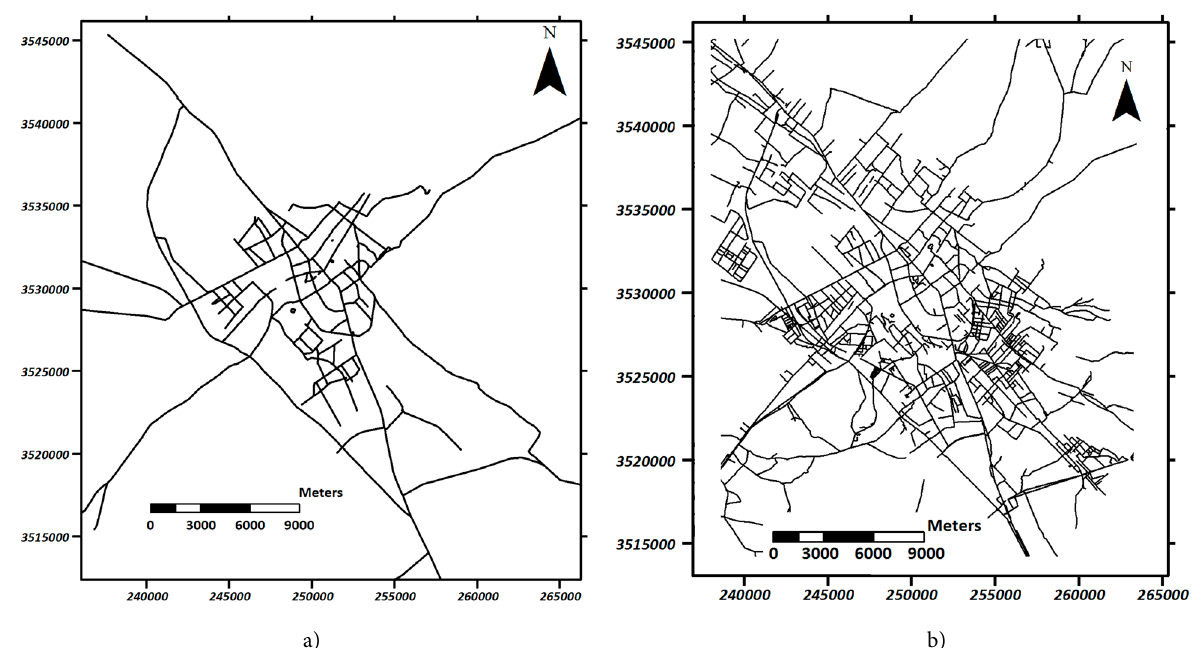
Fig. 15. The urban road dataset used in this article: a) – Reference dataset (1:25000); b) – Target dataset (1:5000)